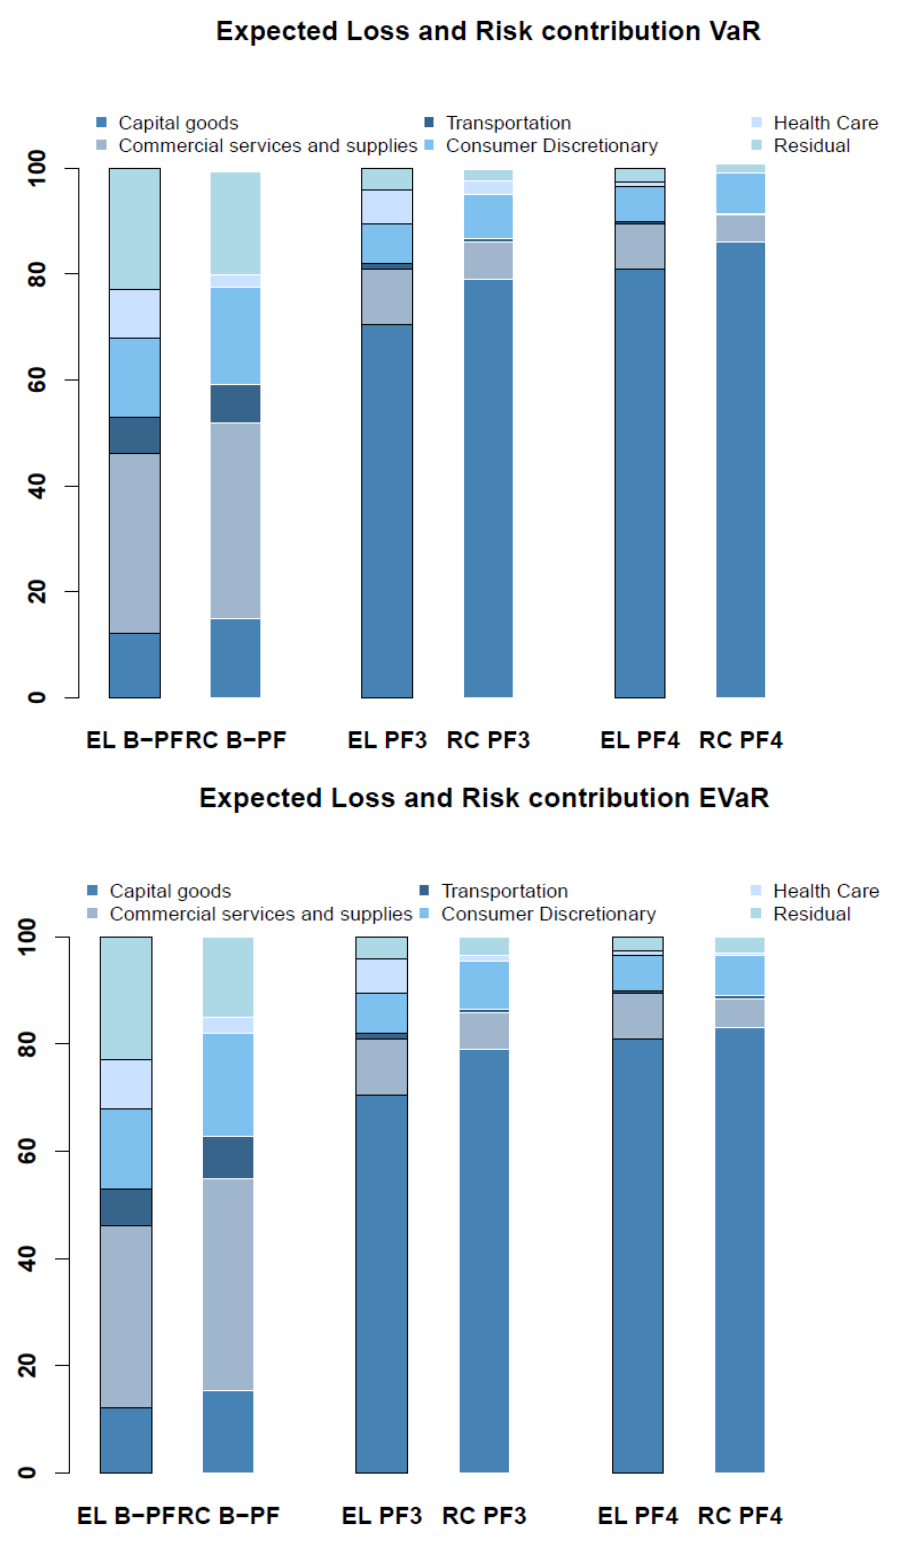
Figure 4. Comparison: Expected loss and risk